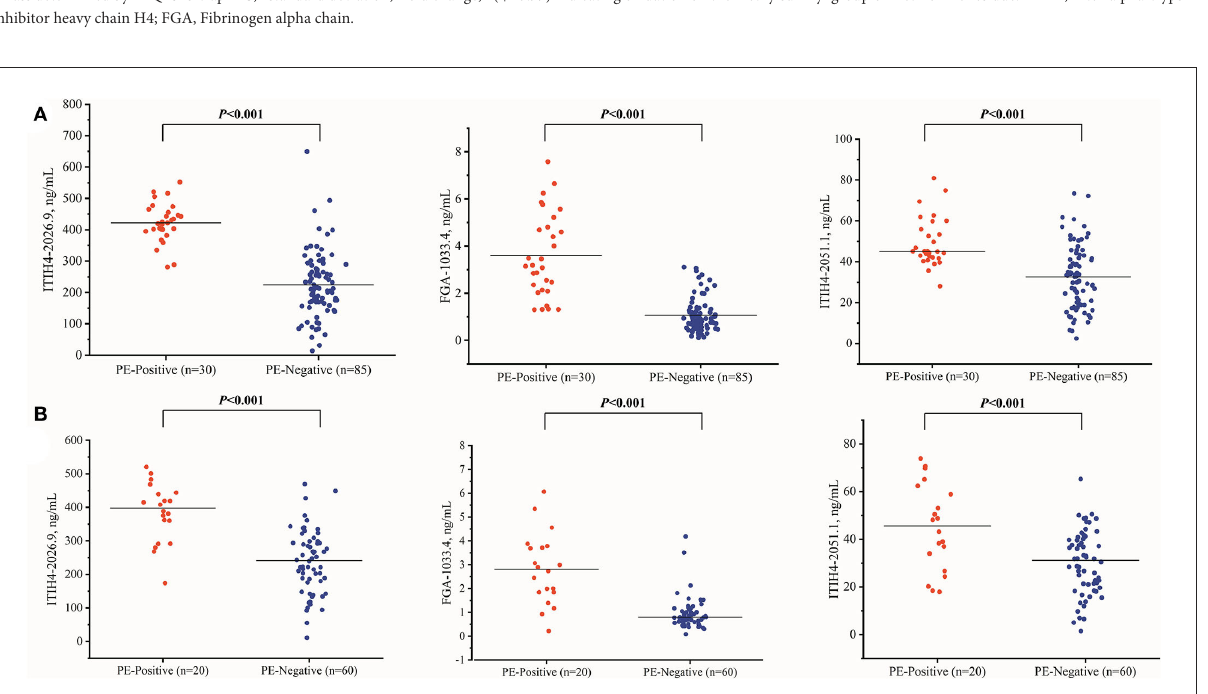
of 85.3%, and NPV of 98.8% at the cutoff determined by the Youden’s index (Table